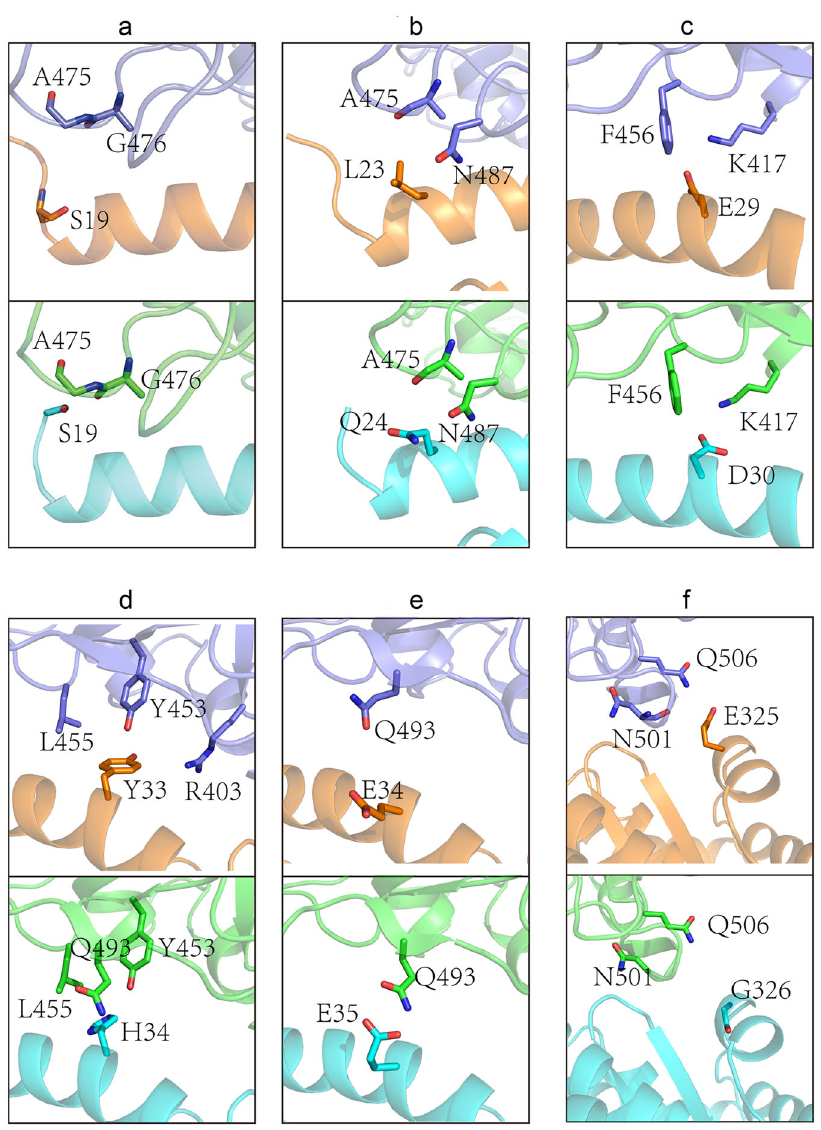
Fig. 3 Comparison of interface residue contacts at speci fi c positions of dACE2 and hACE2. In the RBD/dACE2 complex ( a – f upper panels), RBD residues are colored in light blue, and dACE2 residues are colored in orange. In the RBD/hACE2 complex ( a – f lower panels), RBD residues are colored in green, and hACE2 residues are colored